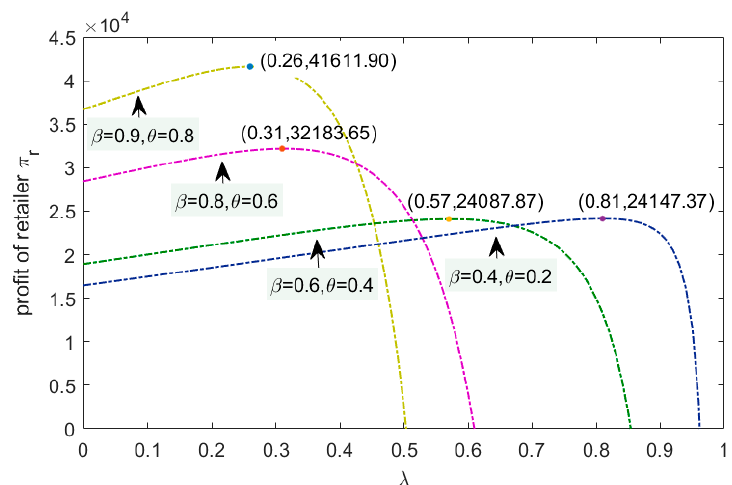
Figure 7. Optimal profit-sharing ratio with β and θ